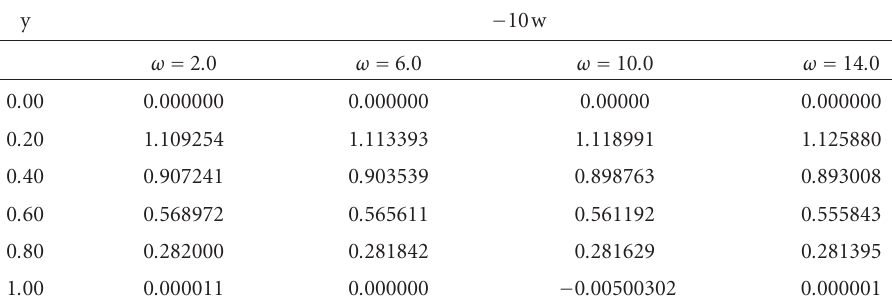
Table 4.1. Cross-flow velocity for S = 1 . 0, Re = 5 . 0, z = 0 . 5, t = 0 . 2, (cid:3) = 0 . 2.